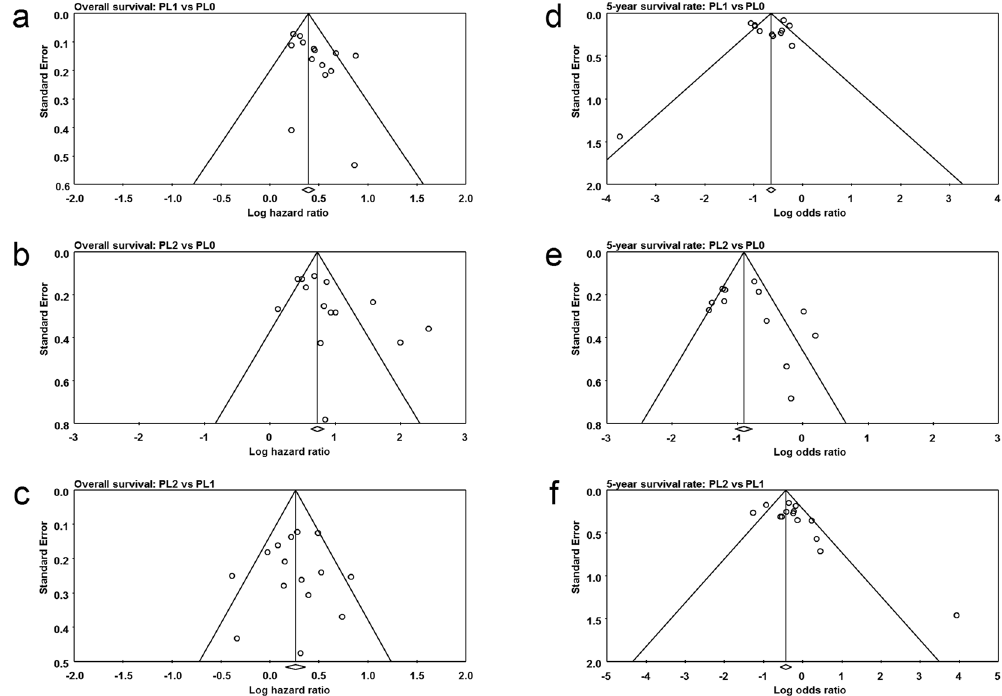
Figure 5. Funnel plots showing the publication bias of overall survival and 5-year survival rate. ( a ) Overall survival: PL1 vs PL0; ( b ) Overall survival: PL2 vs PL0; (3) Overall survival: PL2 vs PL1; ( d ) 5-year survival rate: PL1 vs PL0; ( e ) 5-year survival rate: PL2 vs PL0; ( f ) 5-year survival rate: PL1 vs